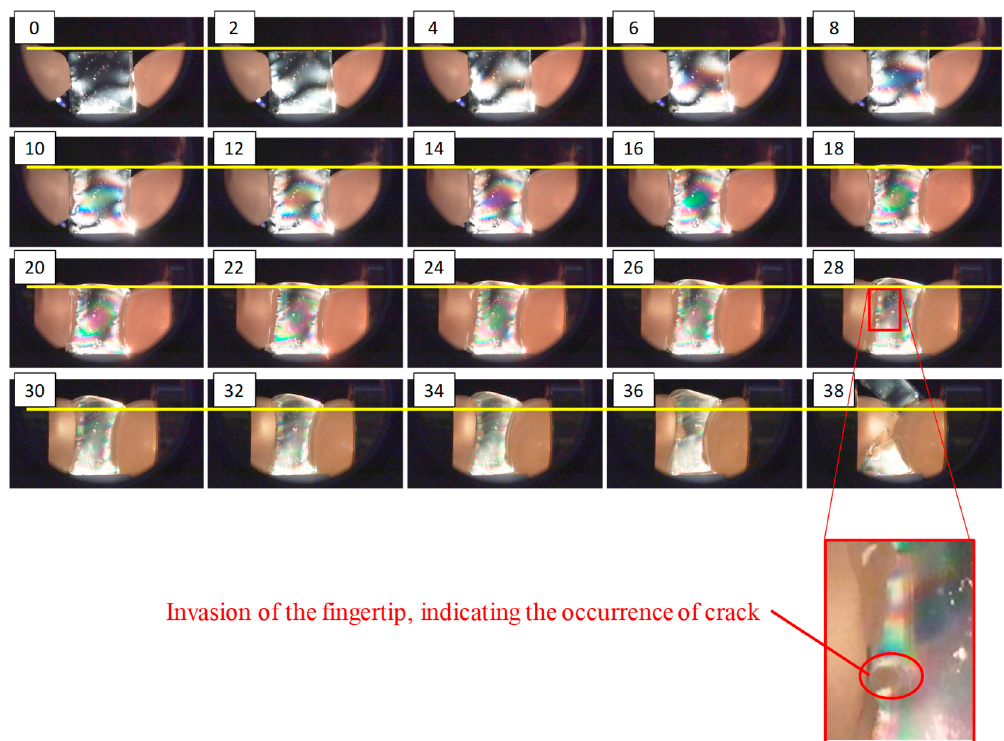
Figure 4. Snapshots of the photoelastic images during the compression test. The number at the upper left of each image is the corresponding pushing distance x [mm] from the occurrence of contact between the object and fingertip. The yellow line indicates the position of the top surface of the object in the initial state.